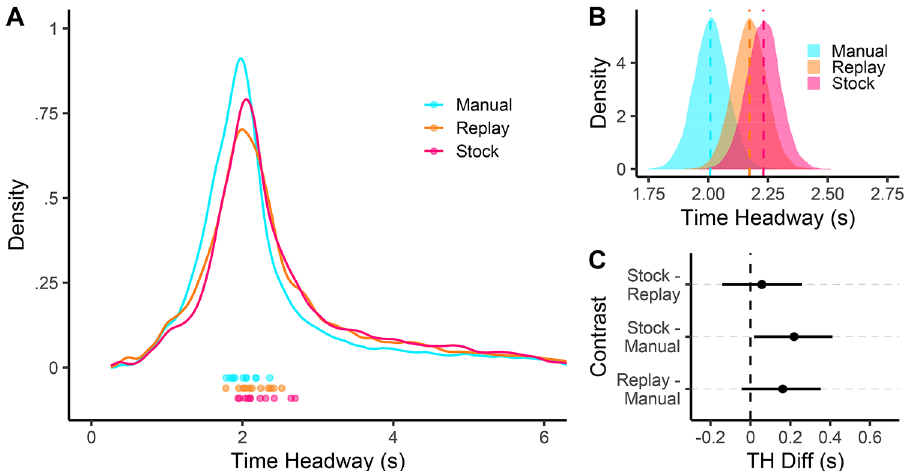
Figure 3. Time headway of gaze. ( A ) The distribution of pooled gaze Time Headway (TH) for each driving mode: Manual (cyan), Auto-Replay (orange) and Auto-Stock (magenta). At the bottom of the graph, the dots correspond to the individual participant’s median time headway for the three conditions. ( B ) The posterior distribution of the condition means (of participant medians) gaze time headway for each condition. Vertical dashed lines correspond to the empirical mean for each condition. ( C ) The posterior estimate of the differences between each condition. Means (dots) and 95% HDIs (bars) are